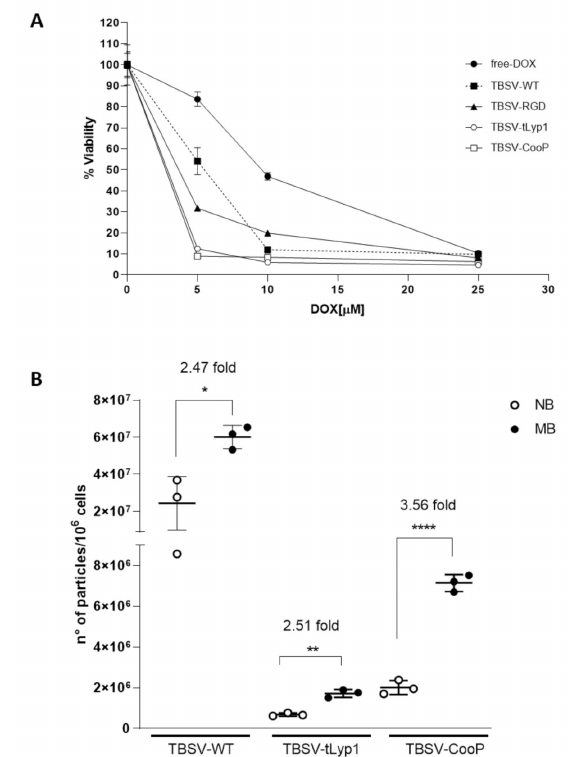
Figure 6. Validation of in vitro and in vivo TBSV targeting to MB. ( A ) Viability of Shh-MB cells after 72 h of incubation with free-DOX or DOX-loaded NPs (TBSV-WT, -RGD, -tLyp1 or -CooP). The viability of the cells treated with the unloaded WT virus was set as 100%. Data are presented as mean ± SD of biological quintuplicates. ( B ) Absolute quantification of TBSV NPs in MB and NB determined by qPCR after IV injection of 200 µ g TBSV-CooP, TBSV-tLyp1 or TBSV-WT in Ptch1 +/ − mice with clear signs and symptoms of MB. Data are presented as mean ± SD of biological triplicates. * p = 0.0171; ** p = 0.0010; **** p < 0.0001 (Student’s t -test). NB—normal brain;